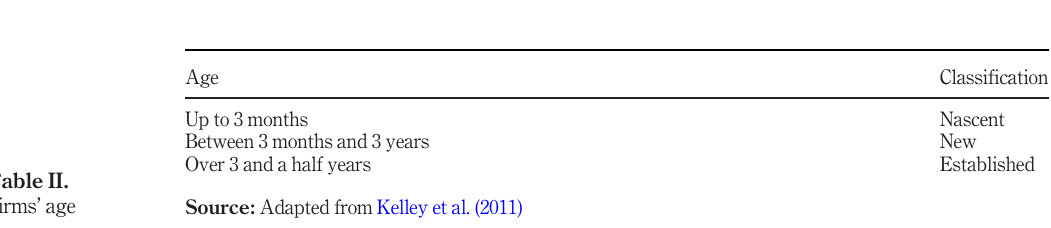
Source: Adapted from Kelley et al.